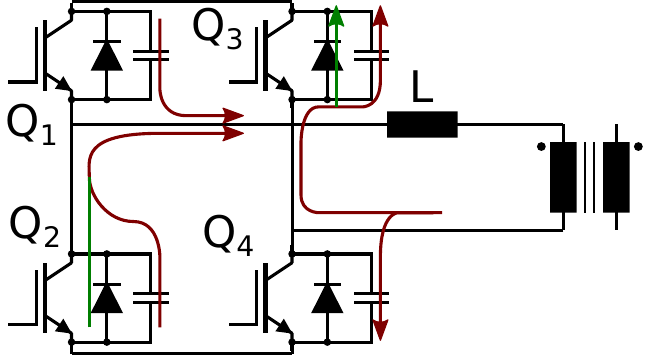
Figure 3. DAB ZVS